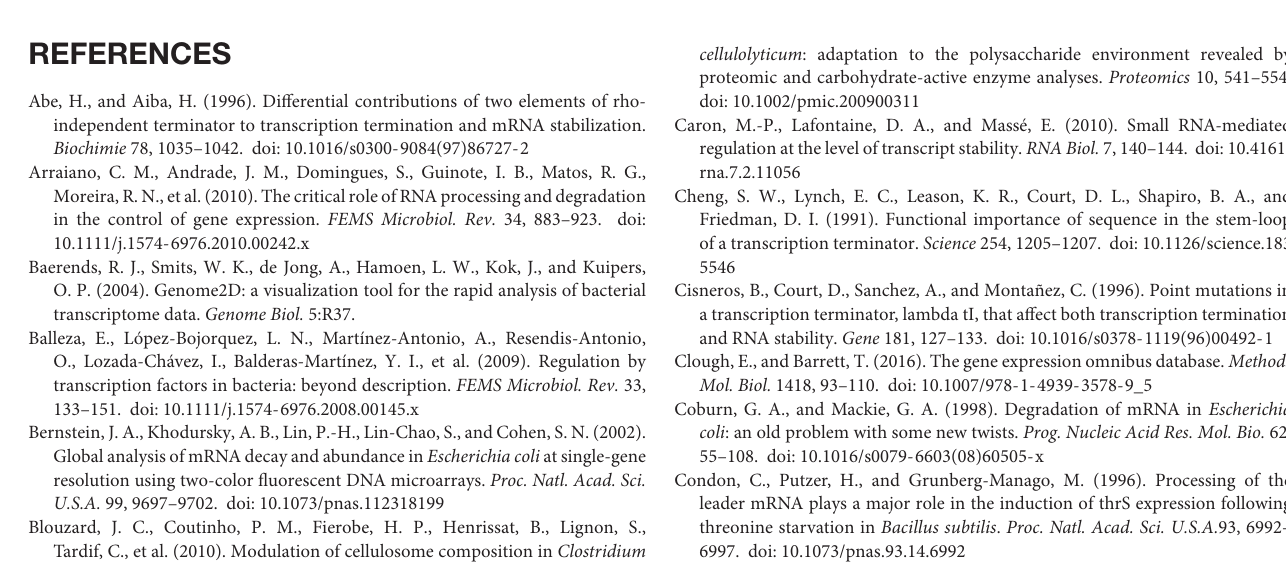
Supplementary Figure 1 | Selection of Stable stem-loops based on the four stability factors. Supplementary Table 1 | Bacterial genomes used in evaluating the SLOFE method. Supplementary Table 2 | Calculation of the normalized read-depth difference (NRD) for the predicted SRPS SLs in Ccel . Supplementary Table 3 | Features of the identified polycistronic SRPS operons with the number of genes and their harbored SLs in C. cellulolyticum . Supplementary Table 4 | Correlation between SLOFE-predicted transcript ratio and those experimentally measured (normalized) for selected operons from Ccel , Cace , Cthe, and Bsub . Supplementary Table 5 | SLOFE-predicted ratios of the SRPS operons from Ccel (A) , Cthe (B) , Cace (C) , and Bsub (D) . Supplementary Table 6 | Pearson correlation coefficients between predicted ratio and experimentally measured ratio (normalized) for the SRPS operons of Ccel , for each of the six methods (CAI, RCA, RCBS, MELP, Gene-order, and SLOFE). Supplementary Table 7 | Pearson correlation coefficients between predicted ratio and experimentally measured ratio (normalized) for the SRPS operons of Cthe , for each of the six methods (CAI, RCA, RCBS, MELP, Gene-order, and SLOFE). Supplementary Table 8 | Pearson correlation coefficients between predicted ratio and experimentally measured ratio (normalized) for the SRPS operons of Cace , for each of the six methods (CAI, RCA, RCBS, MELP, Gene-order, and SLOFE). Supplementary Table 9 | Pearson correlation coefficients between predicted ratio and experimentally measured ratio (normalized) for the SRPS operons of Bsub , for each of the six methods (CAI, RCA, RCBS, MELP, Gene-order, and SLOFE). Supplementary Data 1A | Primer sequences used in the experimental validation of four stem-loops. Supplementary Data 1B | Protein expression extracted from the wild-type of C. cellulolyticum in cellobiose medium using the SDS-PAGE and LC-MS/MS